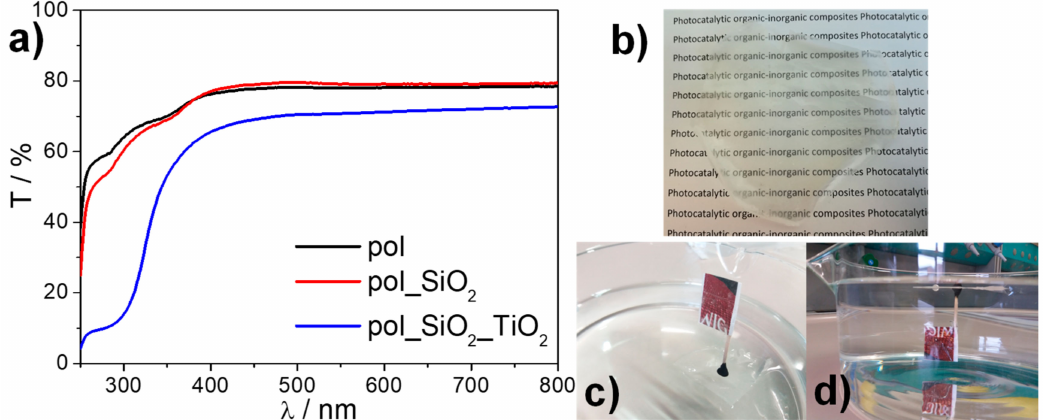
Figure 4. UV-vis transmittance spectra ( a ) and photographs proving the transparency ( b ) and the buoyancy of the composite device on both the mould ( c ) and air sides ( d ); a flag was attached on top of the air side of the transparent device to make it more easily